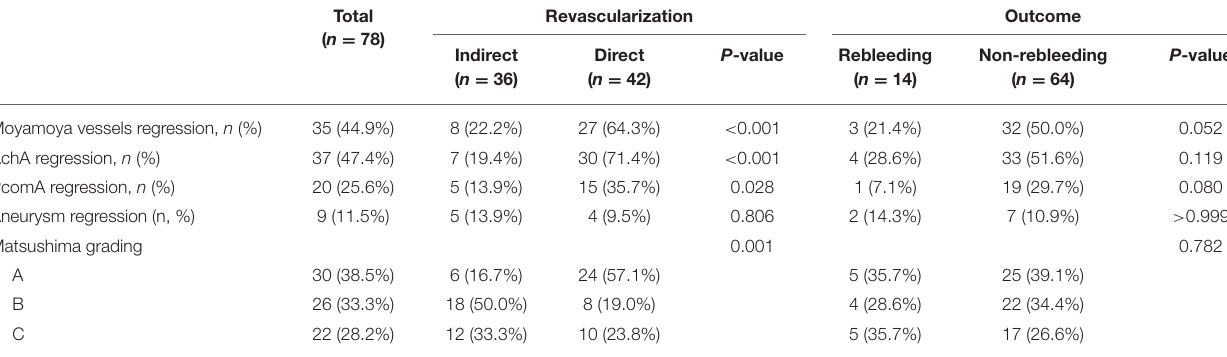
TABLE 6 | The radiological outcomes in 78 operated patients with available follow-up